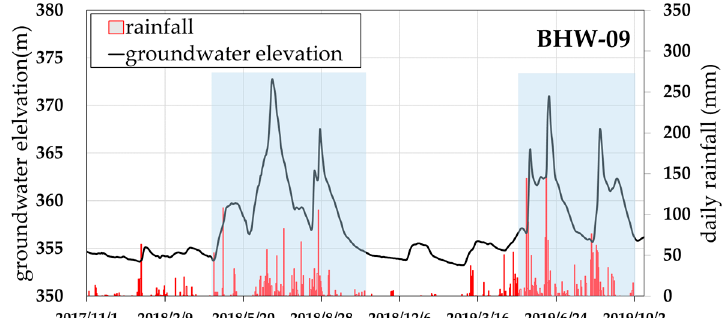
Figure 17. Variation in daily rainfall and groundwater elevation from November 2017 to October 2019 in borehole